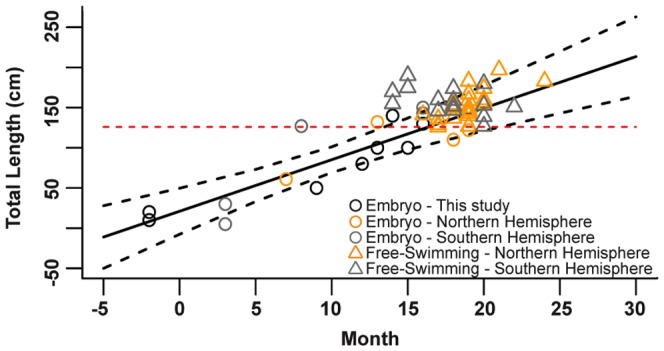
Month of observation and size of white shark embryos and free-swimming juveniles worldwide.Data are for white shark observations in this study and globally. Month zero is January in Northern Hemisphere and July in Southern Hemisphere. For unborn animals, black circles indicate embryos from this study (Northwest Pacific; n = 9); orange circles indicate embryos from the Northern Hemisphere (n = 4), while gray circles indicate embryos from the Southern Hemisphere (n = 5). For free-swimming juvenile sharks, orange triangles indicate individuals from the Northern Hemisphere (n = 18), and gray triangles indicate individuals from the Southern Hemisphere (n = 17). The solid black line indicates the linear regression for embryos from this study, while the dashed black lines indicate the confidence intervals. The red dashed line indicates size at birth.